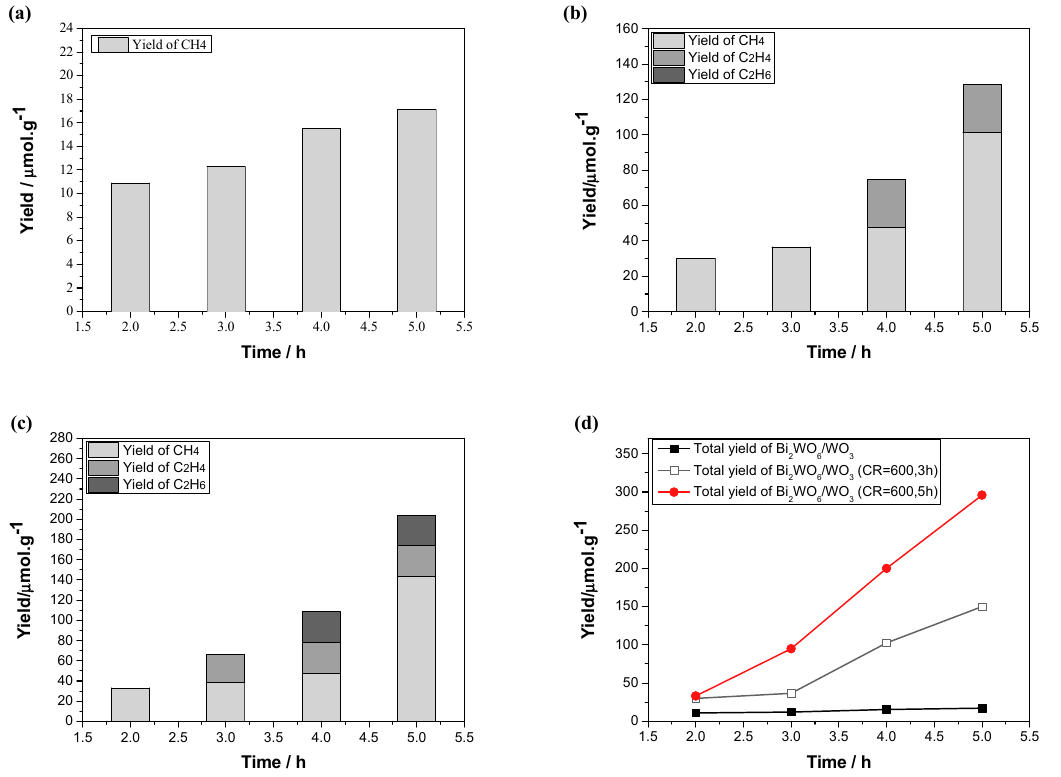
Figure 2. CO 2 photoreduction behavior of different Bi 2 WO 6 /WO 3 under a 300 W Xe lamp (CR = 8, 40 °C). ( a ) Bi 2 WO 6 /WO 3 . ( b ) Bi 2 WO 6 /WO 3 treated for 5 h (natural light, CR = 600, 5 h). ( c ) Bi 2 WO 6 /WO 3 treated for 5 h (natural light, CR = 600, 5 h). ( d ) Total yield based on CO 2